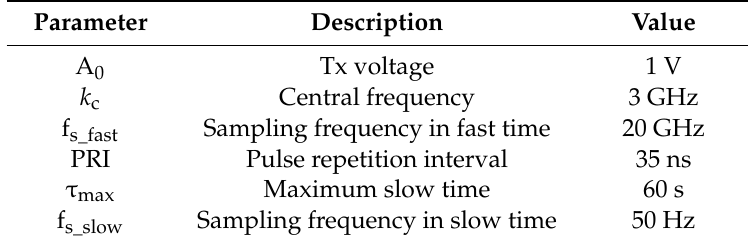
Table 2. Simulation parameters of the through-the-wall UWB switched-antenna-array radar.